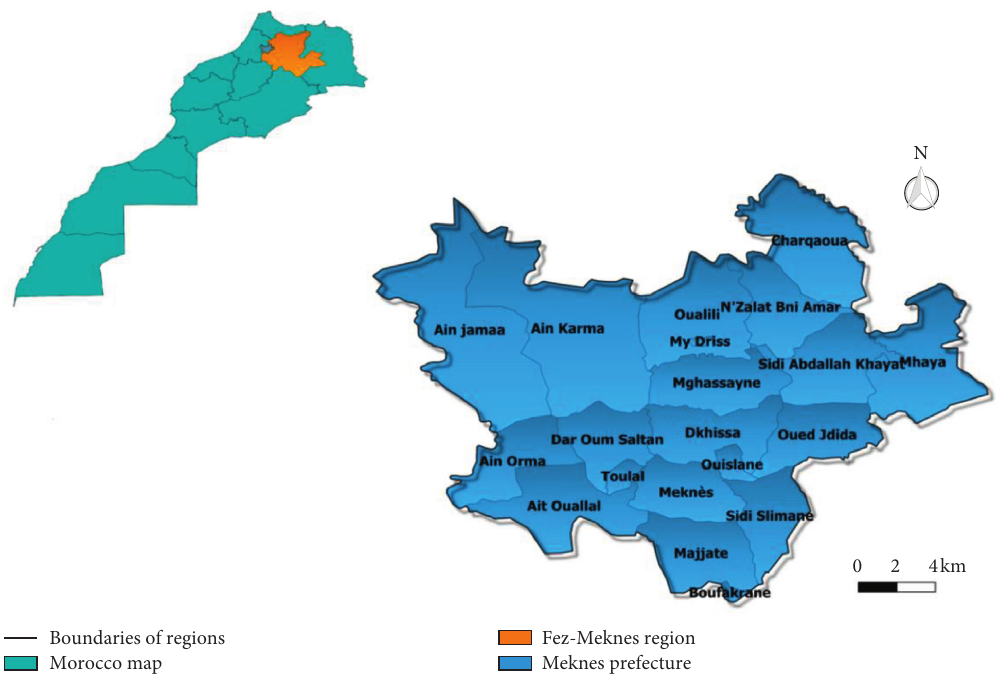
Figure 1: Geographical location of the study